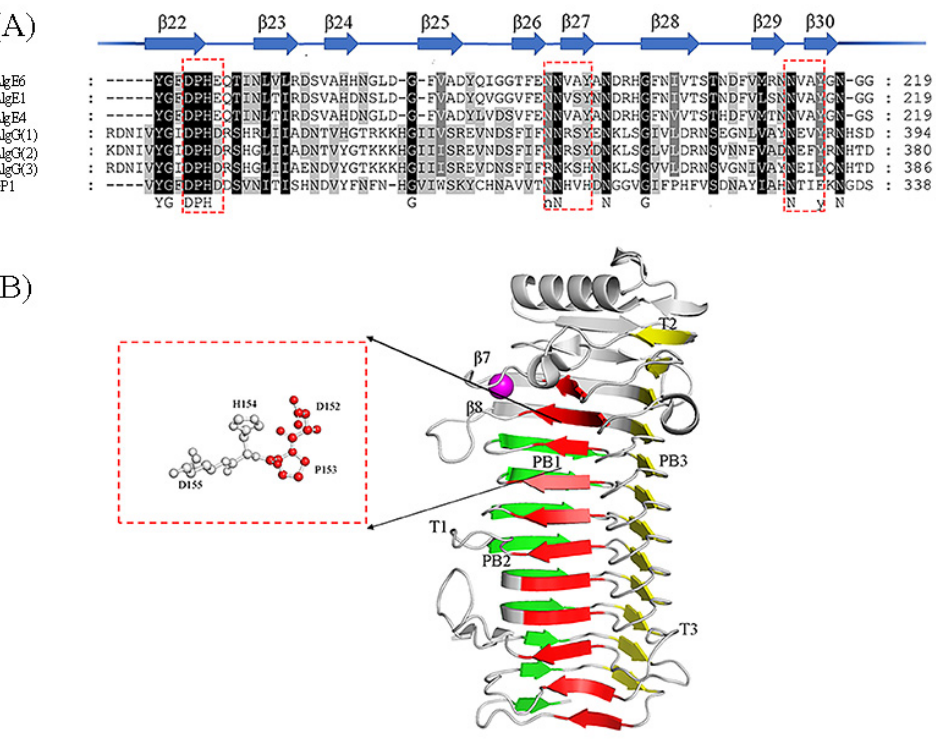
Figure 4. Sequence alignment of ManC5-Es with partial sequence and the structure of AvAlgE4A (PDB: 2PYH [80]). ( A ) Conserved amino acid motif among mannuronan C-5 epimerases. The beta strands and relative positions are represented as arrows and numbers respectively. Red boxes show the highly conserved amino acids. This sequence alignment was created using the following sequences from NCBI and UniProtKB website; The extracellular epimerases AvAlgE1 (UniProtKB: Q44494.1), AvAlgE4 (UniProtKB: Q44493.1), and AvAlgE6 (UniProtKB: Q9ZFH0.1) from A. vinelandii , and PaAlgG(1) proteins from P. aeruginosa (NCBI: WP_003110465.1), PfAlgG(2) proteins from P. fluorescens (UniProtKB: P59828.1) and PsAlgG(3) proteins from P. syringae (NCBI: WP_011103483.1), and GP1 proteins (NCBI: CBN80312.1) from Ectocarpus siliculosis virus . ( B ) Structure of AvAlgE4A, forming a β -helix fold [80]. The red box shows the catalytic sites. The sheets forming the helix are colored in red (PB1), green (PB2), and yellow (PB3). The T1-T3 turns are also included. The Ca 2+ ion was in the loop between strands β 7 and β 8 which could explain the calcium dependence.